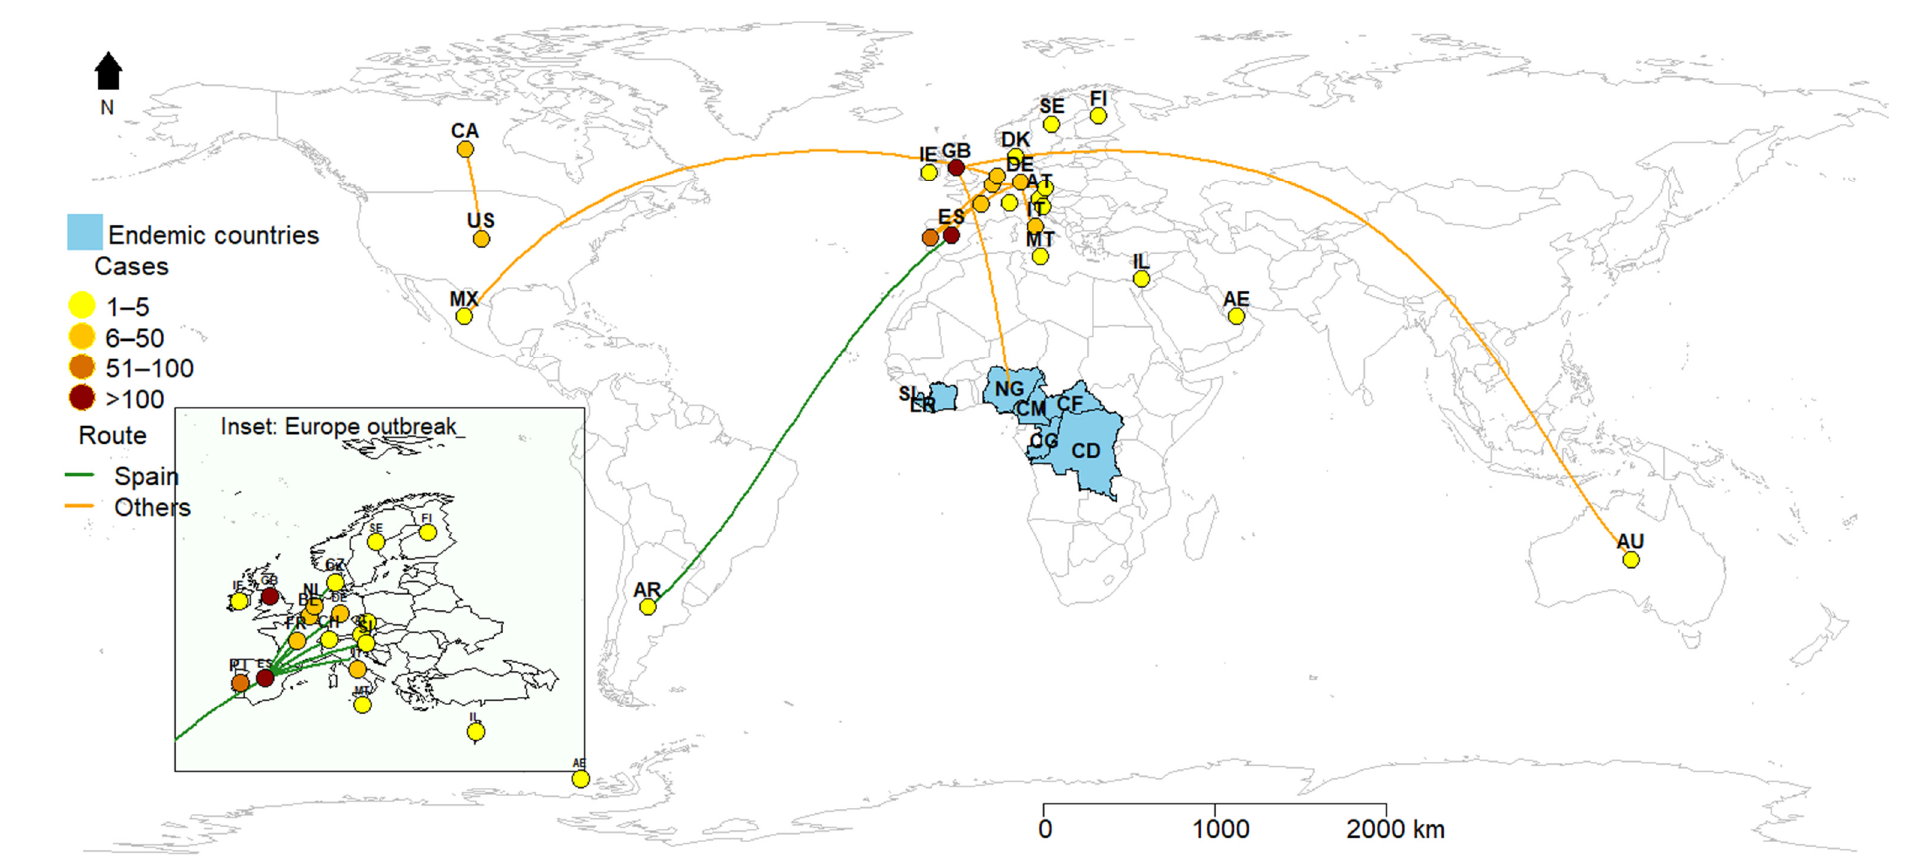
Figure 1. Geographical distribution of the ongoing monkeypox virus (MPXV) outbreaks. MPXV endemic countries have had sporadic epidemics since 2017. Nigeria (15), Cameroon (3), Central African Republic (8), Democratic Republic of Congo (1238), Sierra Leone (0). Note: Non-endemic countries: Argentine (AR), Australia (AU), Austria (AT), Belgium (BE), Canada (CA), Czech Republic (CZ), Denmark (DK), Finland (FI), France (FR), Germany (DE), Ireland (IE), Israel (IL), Italy (IT), Malta (MT), Mexico (MX), The Netherlands (NL), Portugal (PT), Slovenia (SI), Spain (ES), Sweden (SE), Switzerland (CH), United Arab Emirates (AE), UK (GB), USA (US). Endemic countries: Cameroon (CM), Central African Republic (CF), Democratic Republic of the Congo (CD), Liberia (LR), Nigeria (NG), the Republic of the Congo (CG) and Sierra Leone (SL).